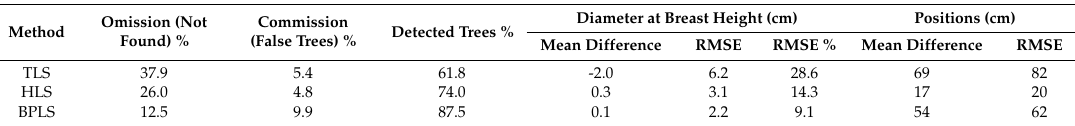
Table 5. Comparison of the results derived from the terrestrial laser scanner (TLS), handheld laser